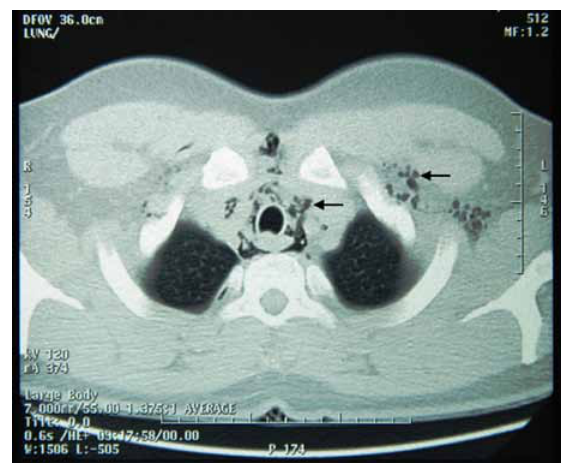
Figure 1. Chest-X Ray, arrows 1-3 pointing the air collections in the mediastinum.